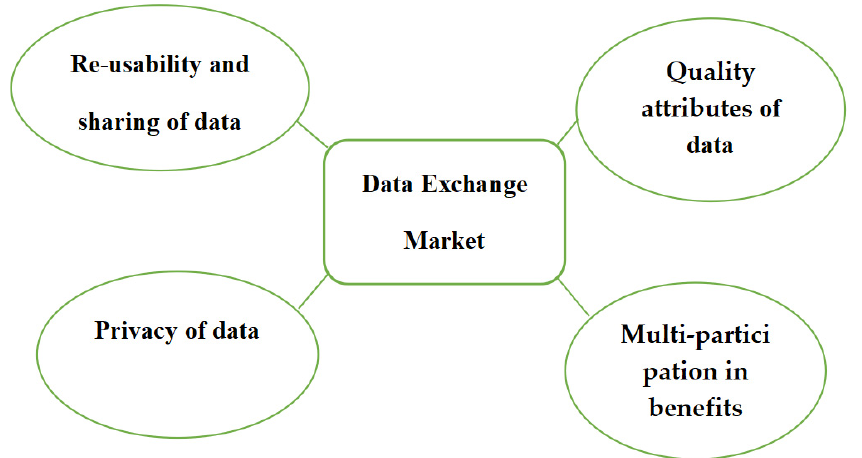
Figure 17. Data market characteristics.